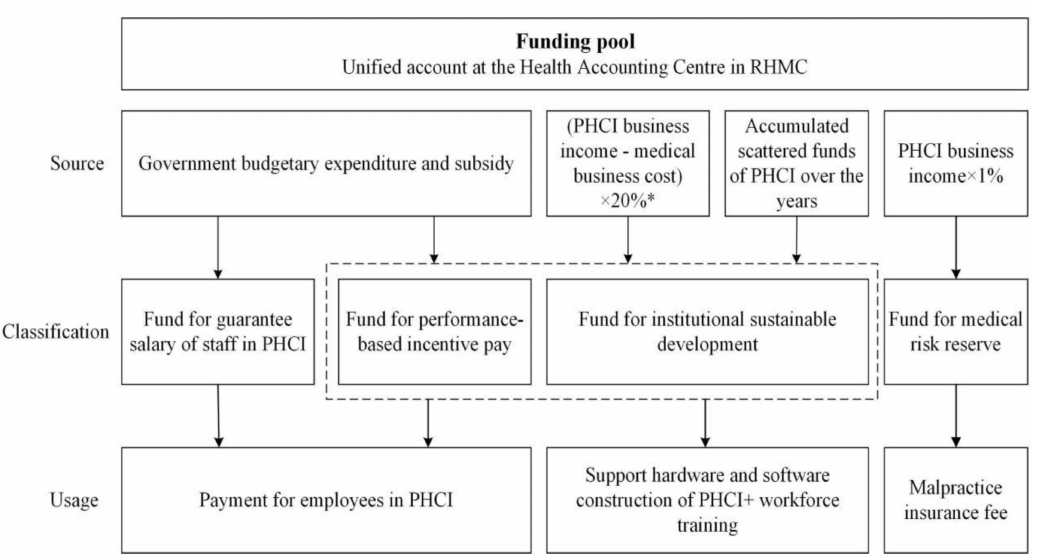
Figure 2. The source, classification, and usage of the funding pool in Pengshui County. * 20%: